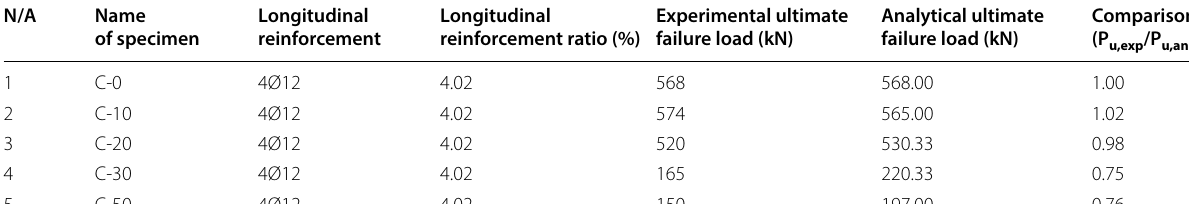
Table 8 Comparison between measured and empirical ultimate failure load.